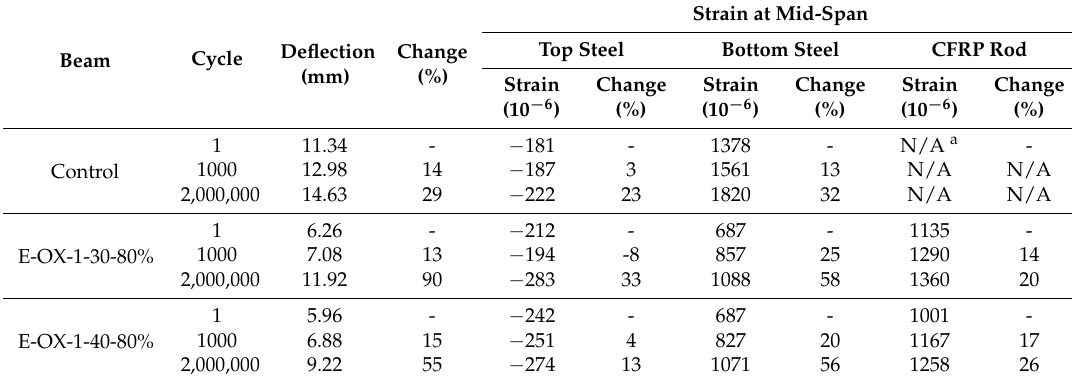
Table 3. Fatigue test results at upper load limit (Concrete strength).